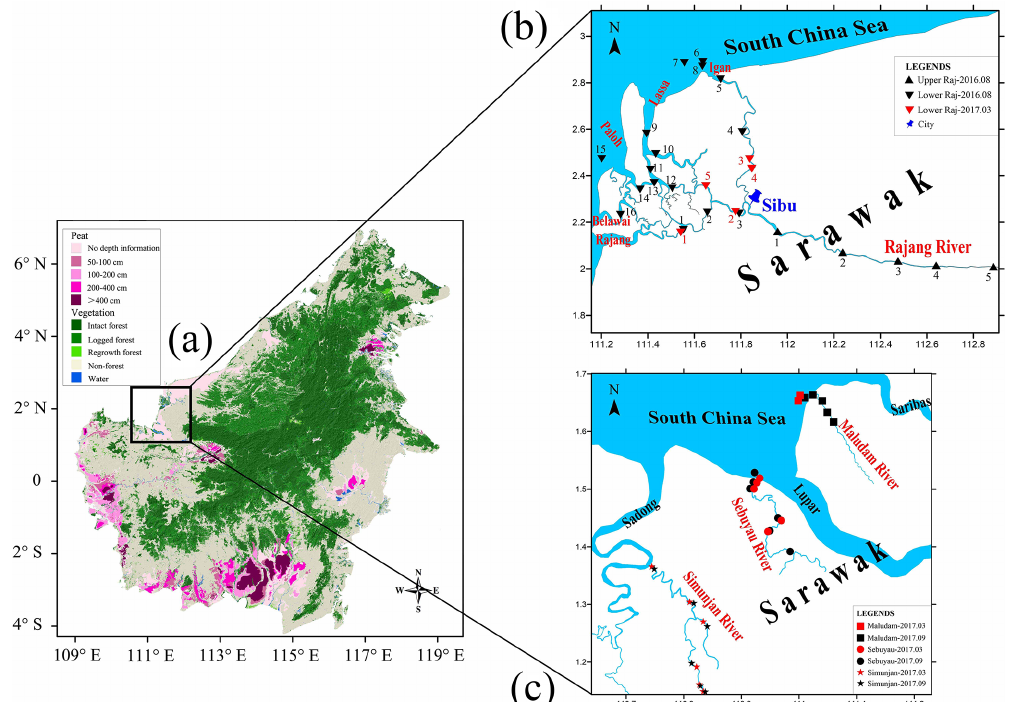
Figure 1. (a) Peat and vegetation distribution in the study region (modified from https://www.cifor.org/map/atlas/, last access: Decem- ber 2018). (b) Sediment sampling sites along the Rajang and its tributaries. The city of Sibu divides the river into its upper and lower reaches. (c) Sediment sampling sites along the three small rivers. Locations of samples collected from the Maludam, Sebuyau, and Simunjan are indicated by squares, circles, and stars,